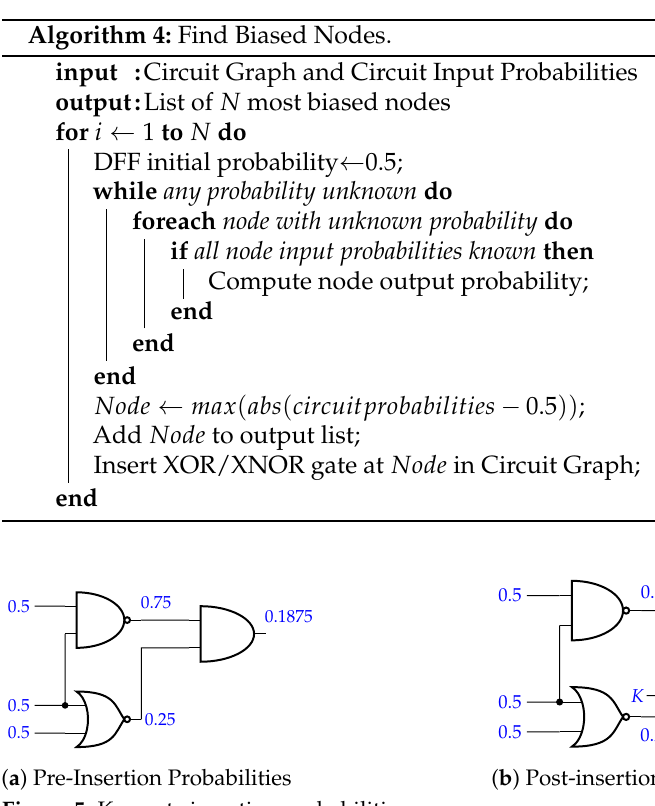
Figure 5. Key gate insertion